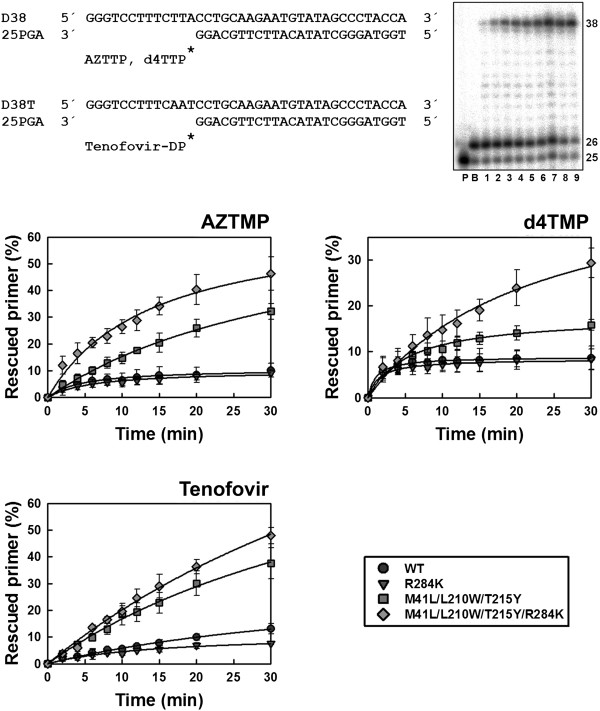
Rescue DNA polymerization initiated from AZTMP-, d4TMP-, and tenofovir-terminated primers annealed to a DNA template. Reactions were carried out with D38/25PGA or D38T/25PGA complexes (sequences given above). The 25-nucleotide primer (lane P) is first blocked with the nucleotide analogue (lane B). The excision of the inhibitor, followed by extension of the primer is achieved after addition of a mixture containing 3.2 mM ATP and the four dNTPs. A fully extended 38-nucleotide product is formed. The gel on the right shows a representative time course experiment of a primer rescue reaction. Lanes 1 to 9 correspond to aliquots removed 2, 4, 6, 8, 10, 12, 15, 20, and 30 minutes after the addition of 3.2 mM ATP. Graphs of time course experiments of primer rescue reactions initiated from inhibitor-terminated primers are given below. All dNTPs in the assays were supplied at 100 μM, except for dATP or dTTP (depending on the reaction) whose concentration was 1 μM. Template-primer and active RT concentrations in these assays were 30 and 24 nM, respectively. The values (averaged ± standard deviations [error bars]) were obtained from three independent experiments.